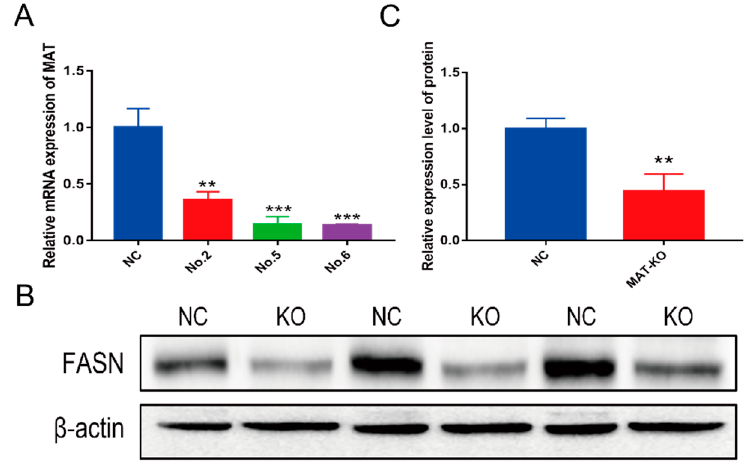
Figure 3. The trial analysis of MAT knockout efficiency. ( A ) MAT knockout efficiency at mRNA level. NC—negative control cells; NO.1—cells knockout by sgRNA 1; and others in the same way. ( B ) Protein changes of FASN in knockout cells. KO—MAT-knockout group ( C ); quantitative analysis of protein; MAT-KO—MAT-knockout group; ** p < 0.01, *** p < 0.001.